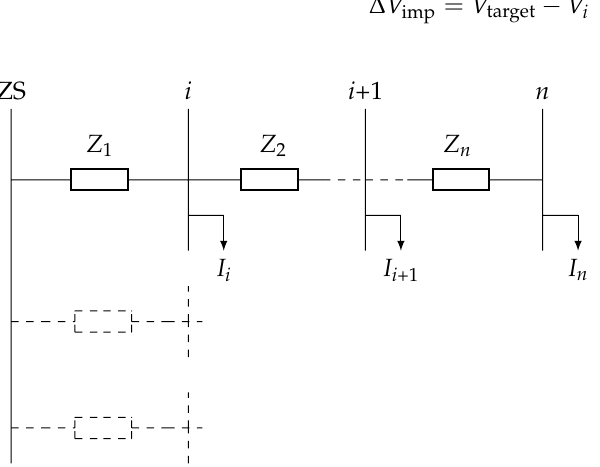
Figure 1. Per unit equivalent circuit across an MV and LV